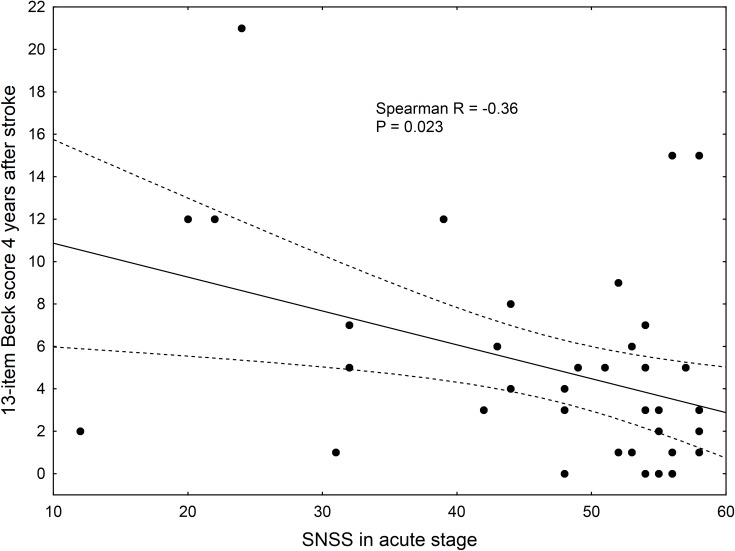
More severe signs of stroke in the acute stage are associated with more severe depressive symptoms 4 years after stroke.The dotted lines denote 95% confidence interval around the regression line. SNSS: Scandinavian Neurological Stroke Scale score (higher scores mean less stroke severity).